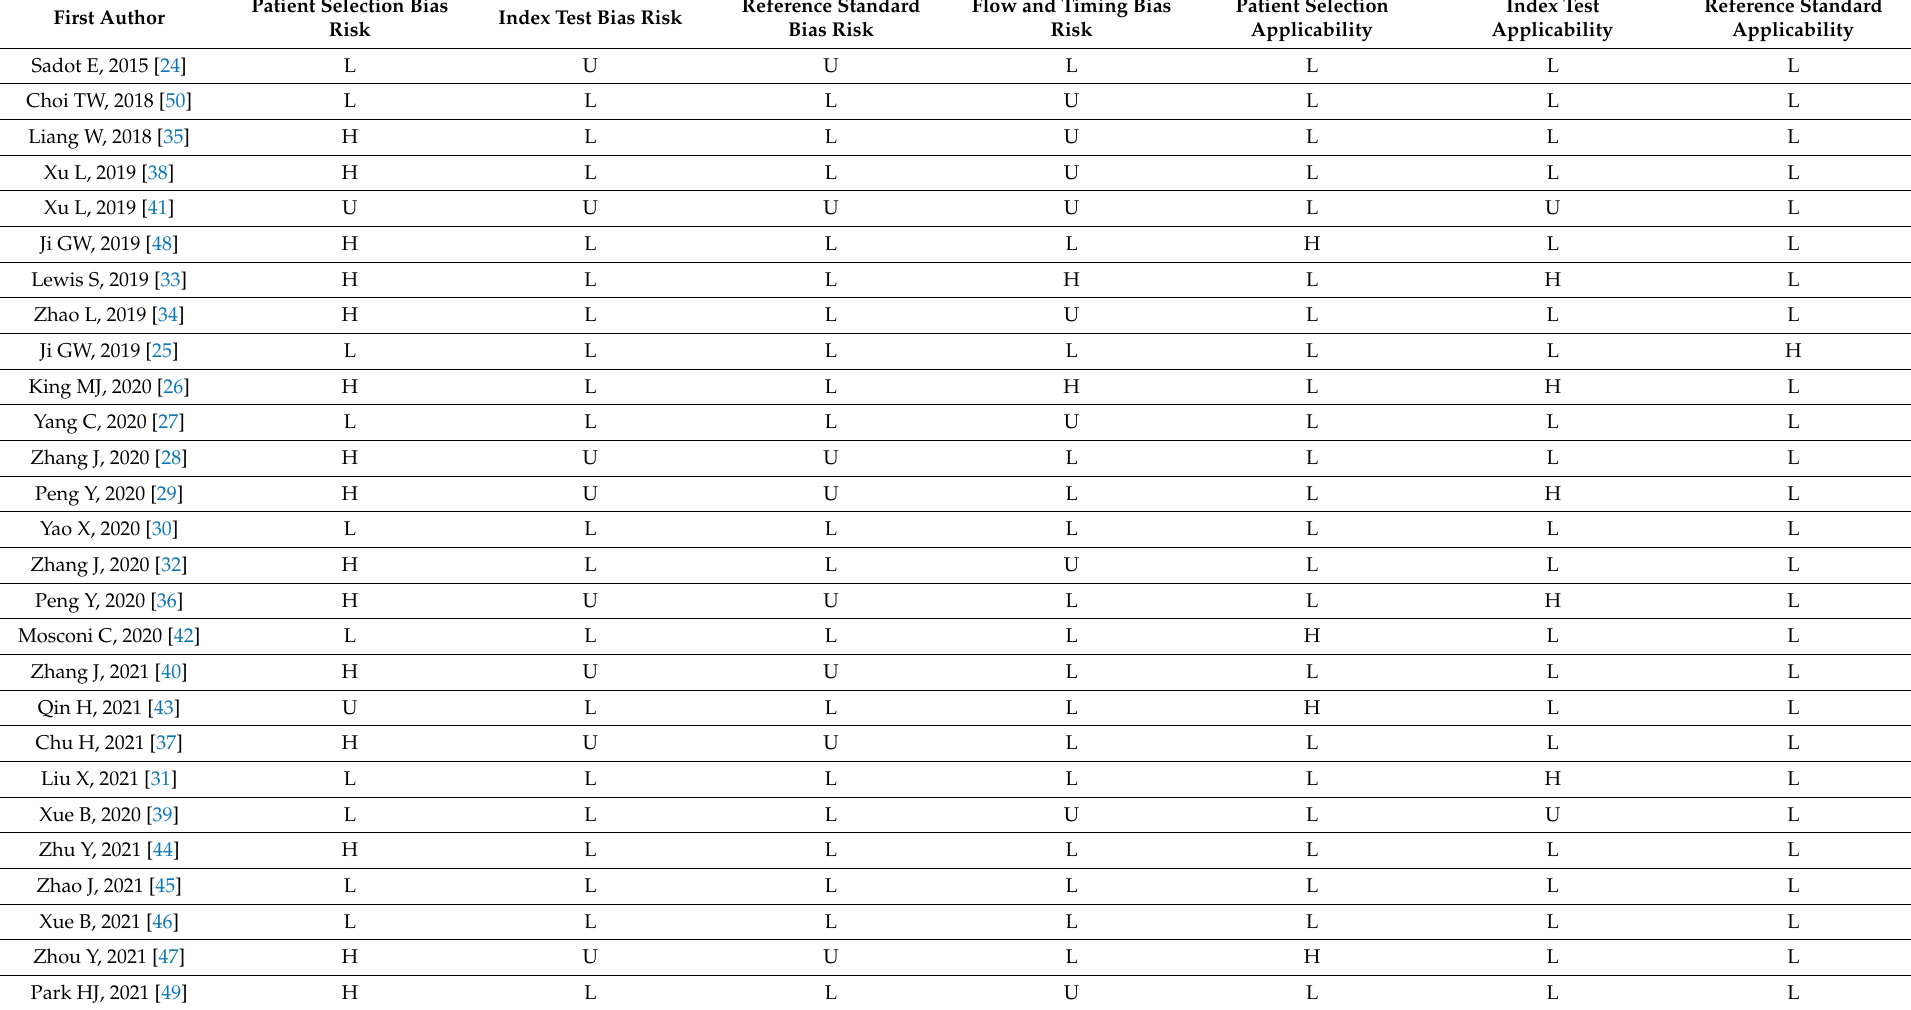
Table 2. QUADAS-2 score of the analyzed